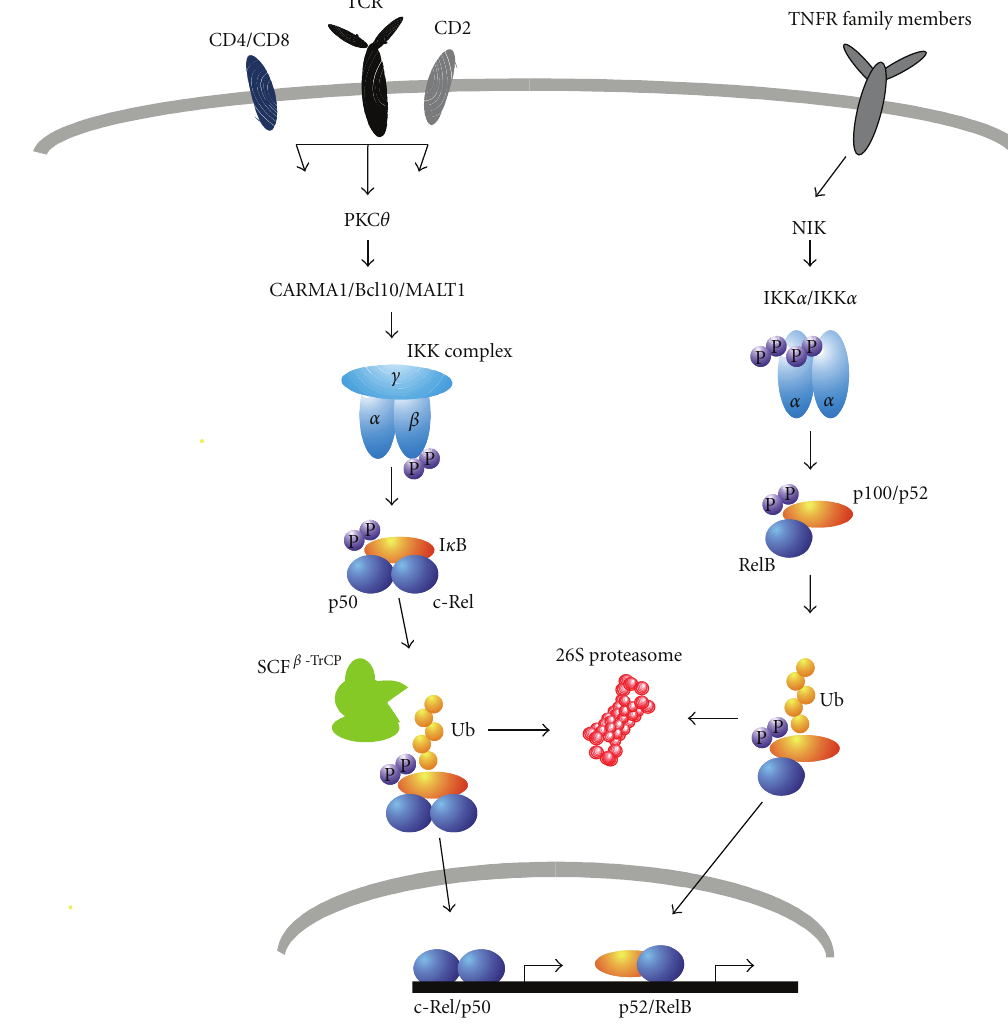
Figure 1: Canonical and alternative NF- κ B activation pathways in T cells. Several signals are required for the activation of the canonical NF- κ B-signalling pathway. The inhibitory I κ B proteins typically bind to dimers of the NF- κ B family such as p65/p50 (not shown in the figure) and c-Rel/p50 to generate inactive complexes that are sequestered in the cytosol. PKC θ is a central molecule for TCR-mediated NF- κ B activation. Phosphorylation of CARMA by PKC θ results in formation of stable CARMA/Bcl10/MALT1 complex and activation of IKK. Activated IKK β kinase mediates phosphorylation of I κ B molecules and recruitment of SCF β -TrCP ubiquitin ligase. Activation of alternative NF- κ B pathway is triggered by a subset of TNFR family members and is mediated by NIK and IKK α that phosphorylates p100. The ubiquitin- proteasome pathway is involved in activation of NF- κ B via specific degradation of I κ Bs and processing of p100 to produce